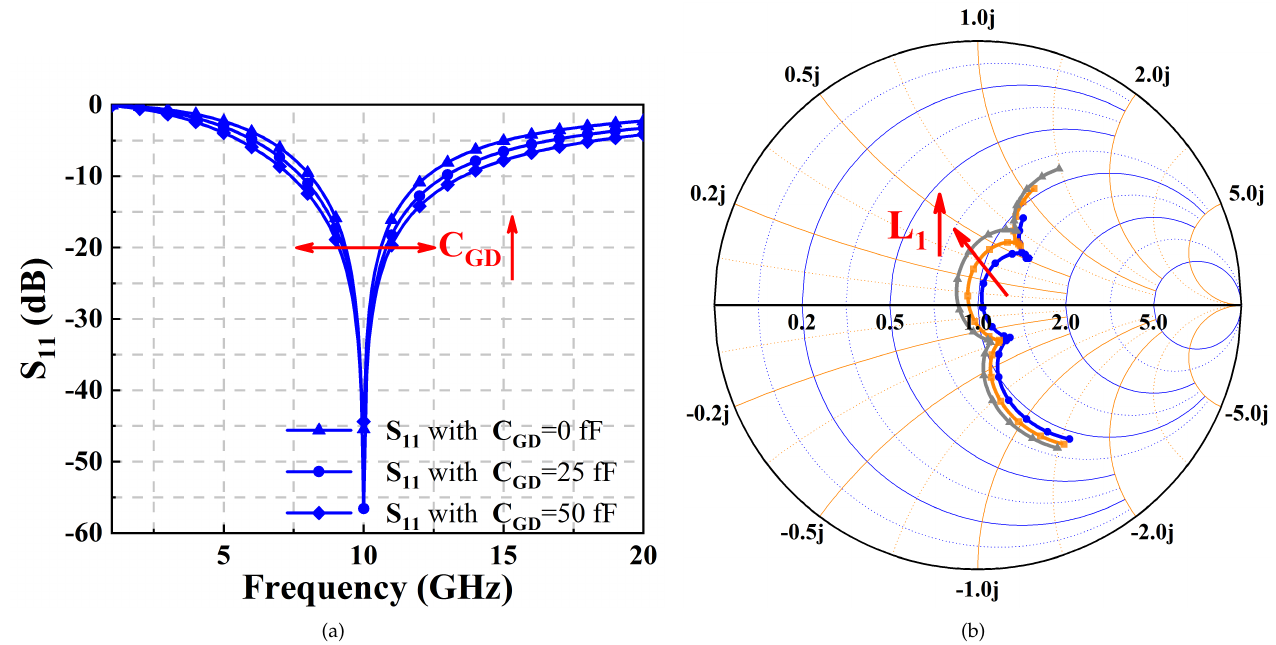
Figure 2. ( a ) Conceptual diagram of bandwidth extension with C GD compensation of S 11 in dB format; ( b ) simulated S 11 with L 1 increasing from 100 pH to 300 pH in the Smith chart